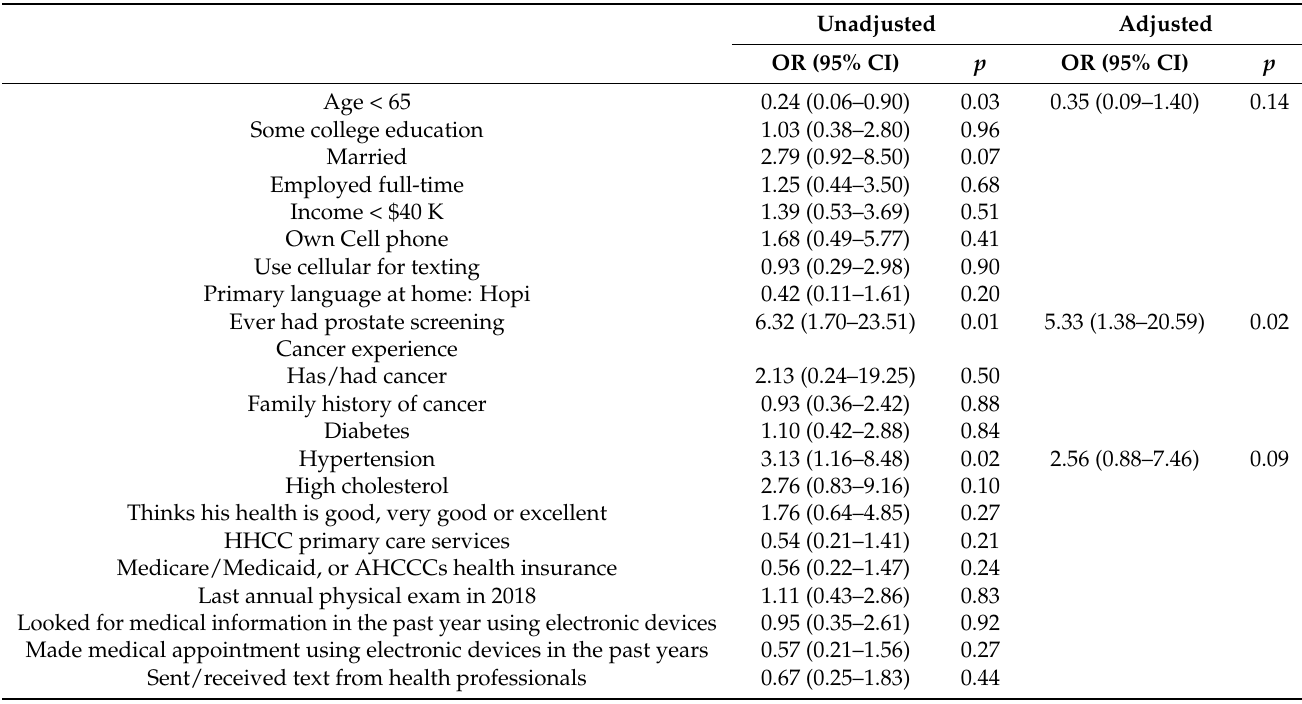
Table 3. Identification of factors associated with having CRC screening for Hopi men with age ≥